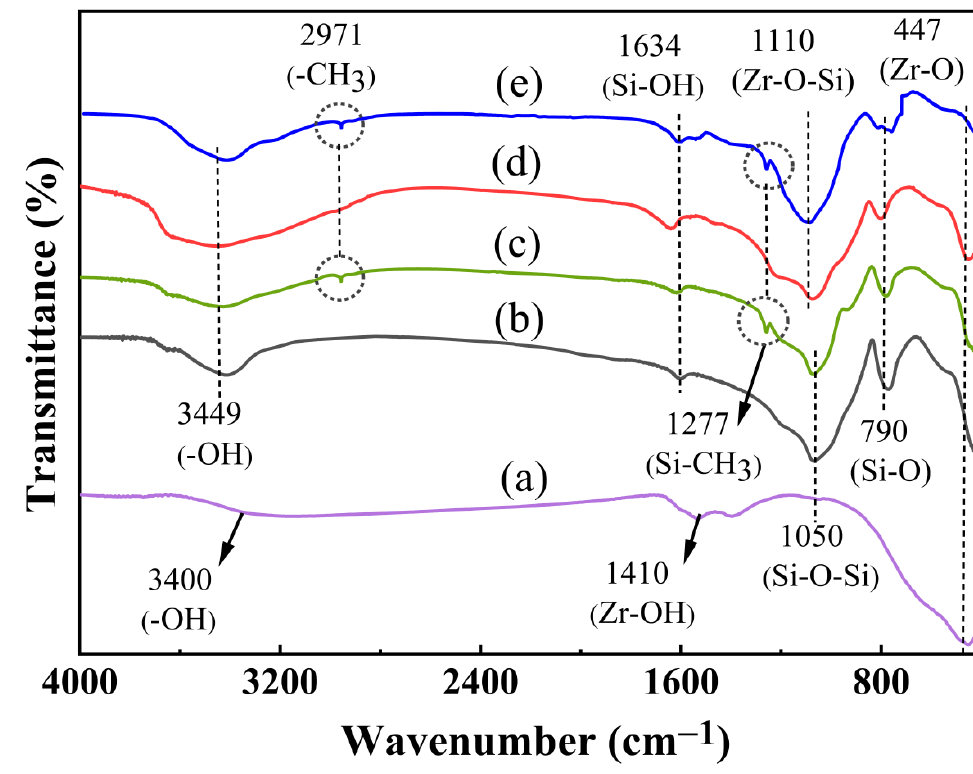
Figure 2. FTIR spectra comparison of (a) ZrO 2 , (b) hydrophilic SiO 2 , (c) hydrophobic SiO 2 , (d) hydrophilic ZrO 2 -SiO 2, and (e) hydrophobic ZrO 2 -SiO 2 xerogels.